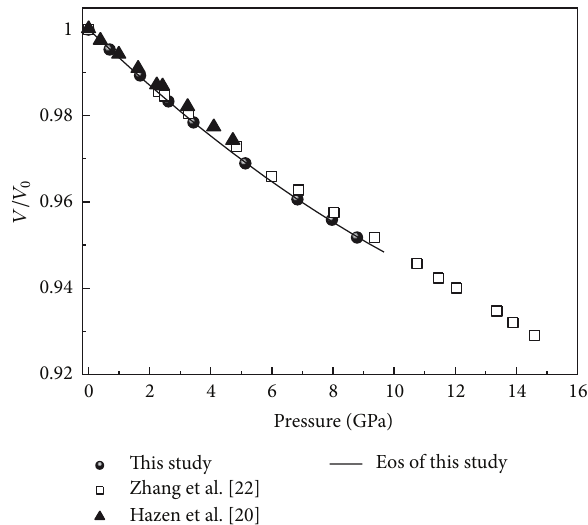
Figure 3: Volume compression of synthetic Mg 3 Y 2 (SiO 4 ) 3 at high pressure and room temperature.